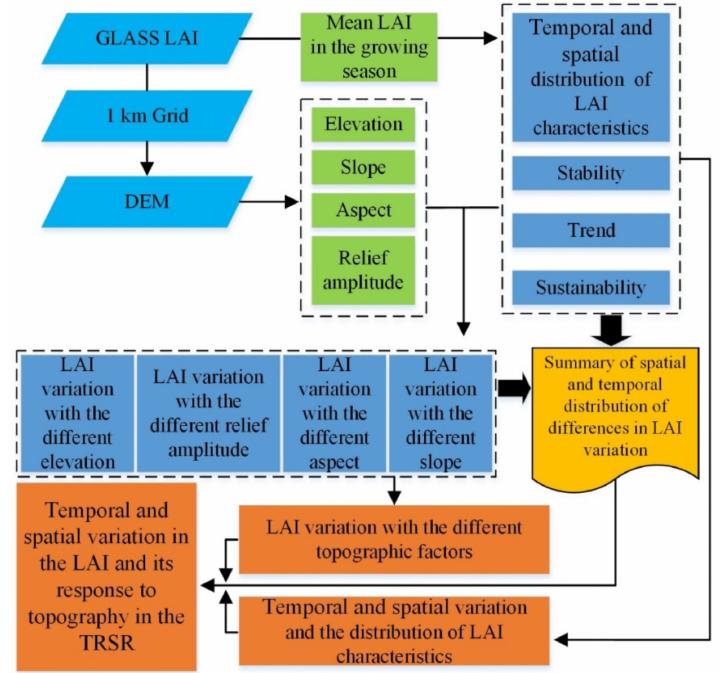
Figure 1. Flowchart of the study